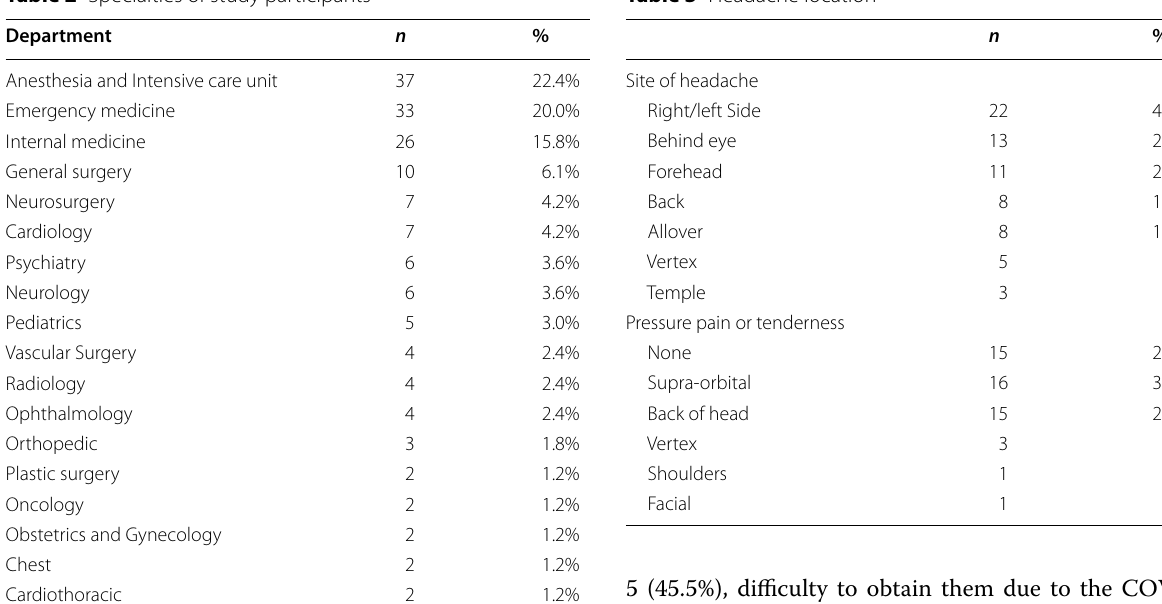
Table 2 Specialties of study participants